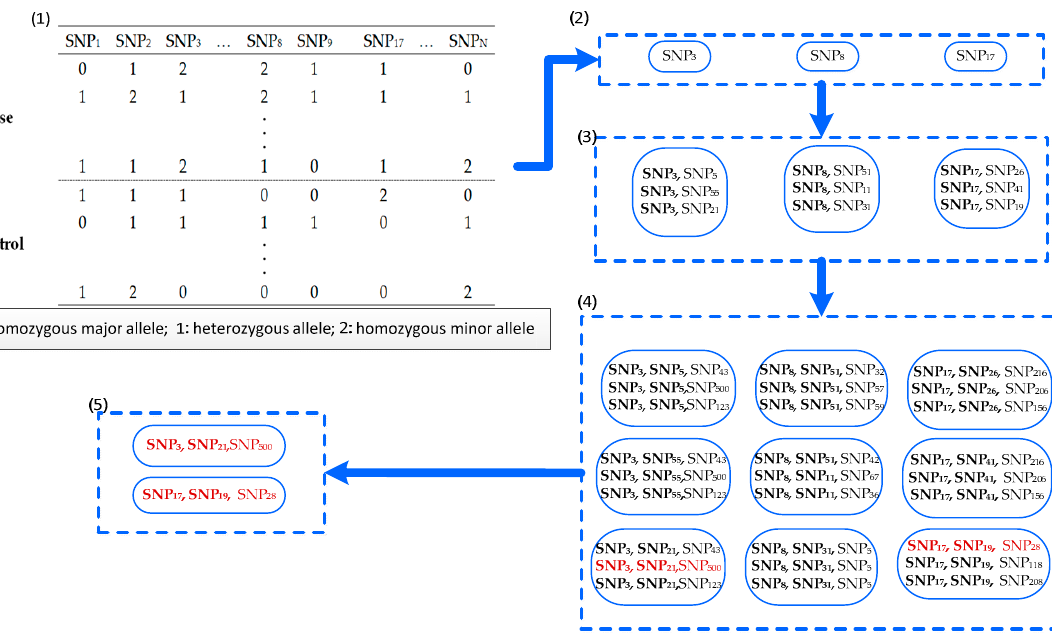
Figure 1. An example of the fast approach for detecting high-order epistasis with interaction weight (FDHE-IW) approach for detecting 3-way single nucleotide polymorphism (SNP) combinations associated with a given phenotype. (1) Using the dataset with N SNPs, the SU value of each SNP was calculated. (2) The top three SNPs with the largest SU values were selected from the N SNPs, and then the three SNPs were employed as seeds to calculate the 2-way interaction weights ( IW ) with the other SNPs. (3) The top nine 2-way SNP-combinations were selected from the 2-way SNP combinations that pair with the three parent SNPs from (2), based on IW values. (4) The top 9 × 3 = 27 3-way SNP-combinations that are formed from a parent SNP-combination in (3) were selected based on IW . (5) The G -test statistical method was employed to test the 27 3-way SNP combinations, and two 3-way SNP combinations were verified using the G-test.